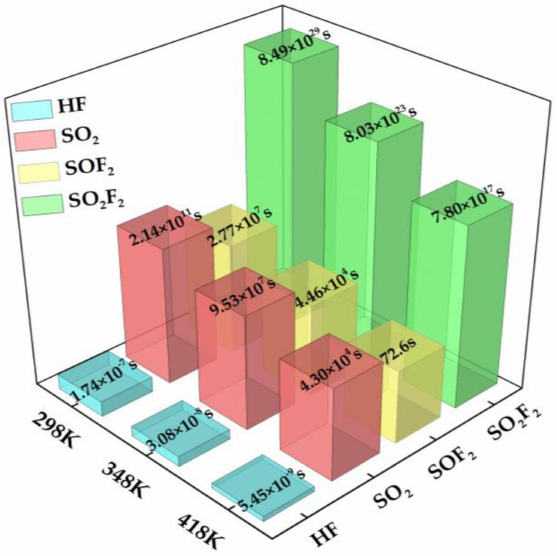
Figure 7. Recovery time of four adsorption systems at various